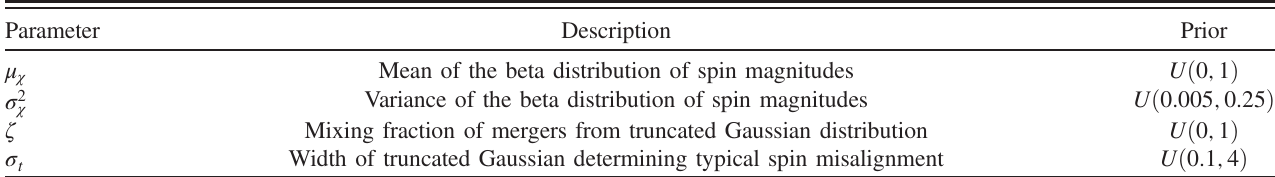
TABLE XII. Summary of D EFAULT spin parameters.